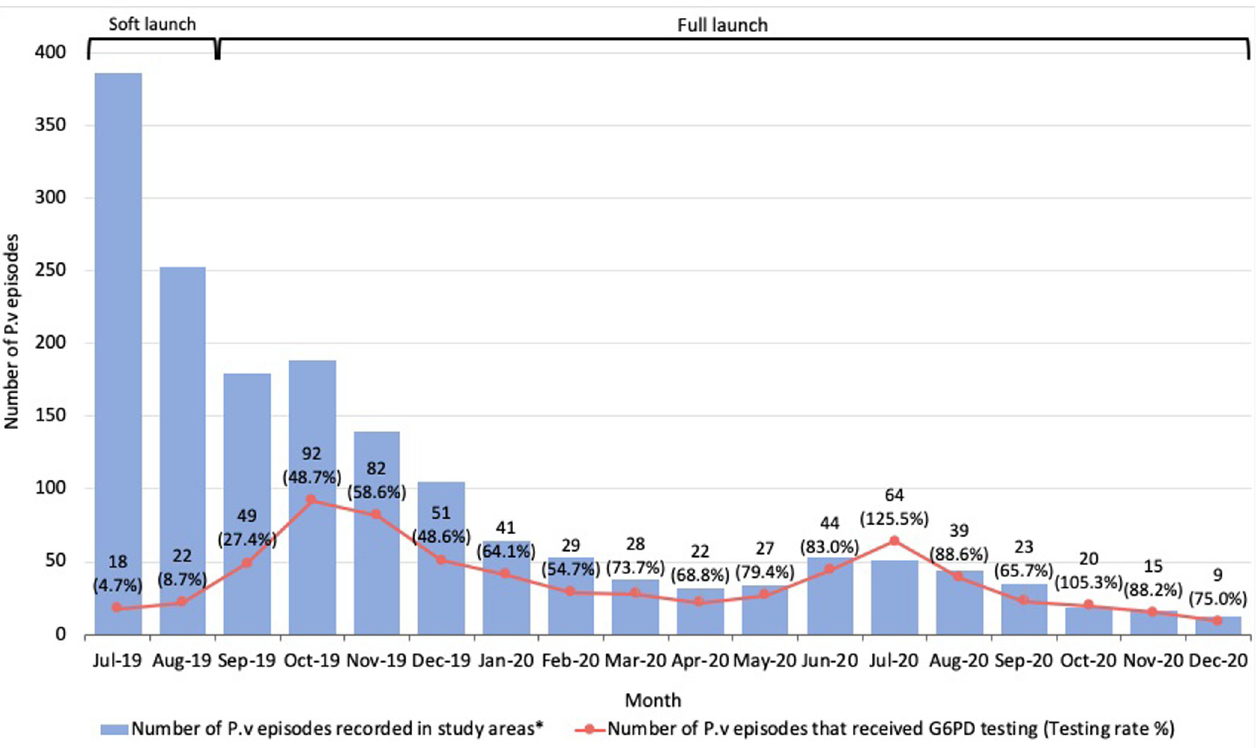
Fig 4. Number of P . v episodes and G6PD testing rate in study areas, by month. P.v = Plasmodium vivax . G6PD = glucose-6-phosphate dehydrogenase. � According to national MIS data. † G6PD testing using qualitative test (CareStart TM rapid diagnostic test) for males and quantitative test (CareStart TM Biosensor or STANDARD TM Biosensor) for